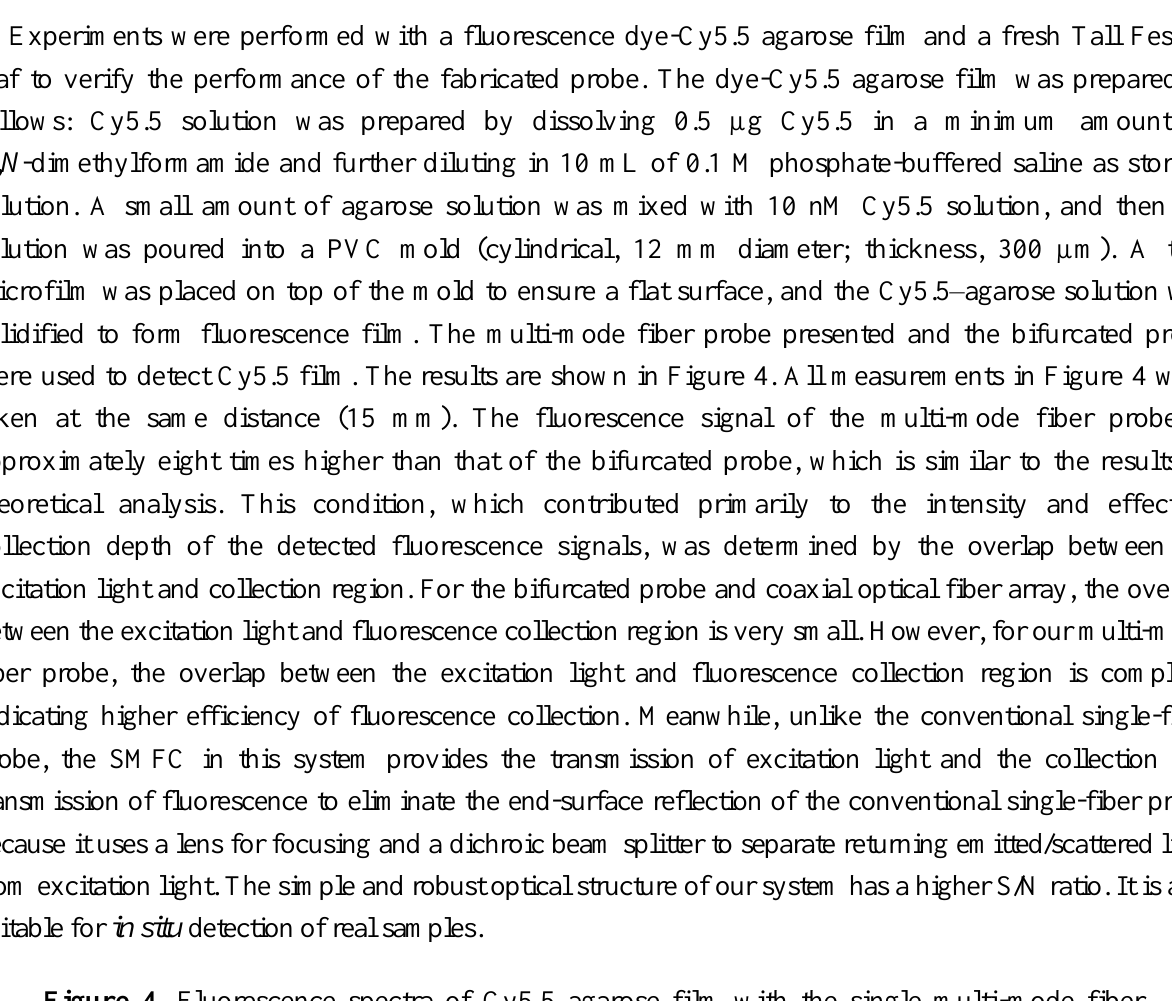
Figure 4. Fluorescence spectra of Cy5.5 agarose film with the single multi-mode fiber probe and bifurcated probe, respectively. The fluorescence spectra were measured at 200 µW and at an acquisition time of 100